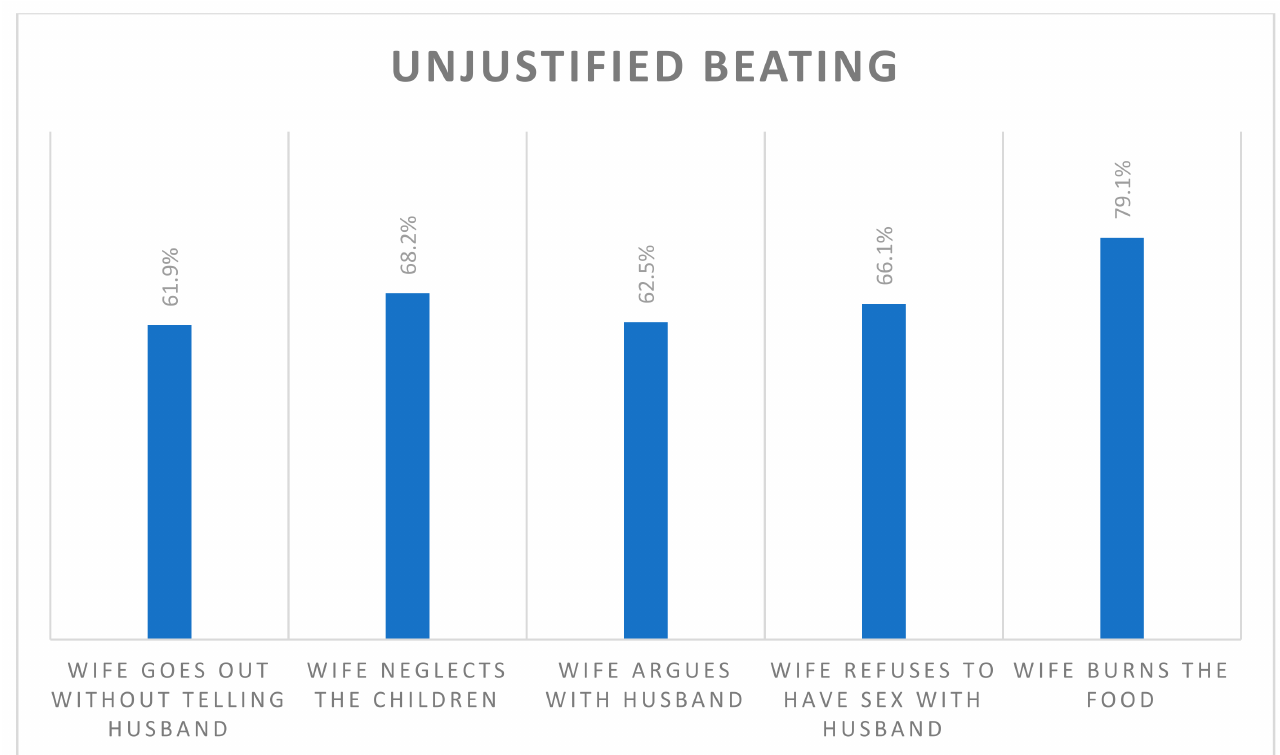
Figure 2. Wife beating was unjustified on different matters. Of the total 4216 women, 39.8% were aged 25–35 years, while more than half were from rural areas ( n = 2181, 51.7%), and the majority were from KPK ( n = 1685, 40.0%), belonged to the poorest and poor wealth quantiles ( n = 1785, 42.4%), were not educated ( n = 2165, 51.4%), and were not working ( n = 3542, 84.1%) (Table